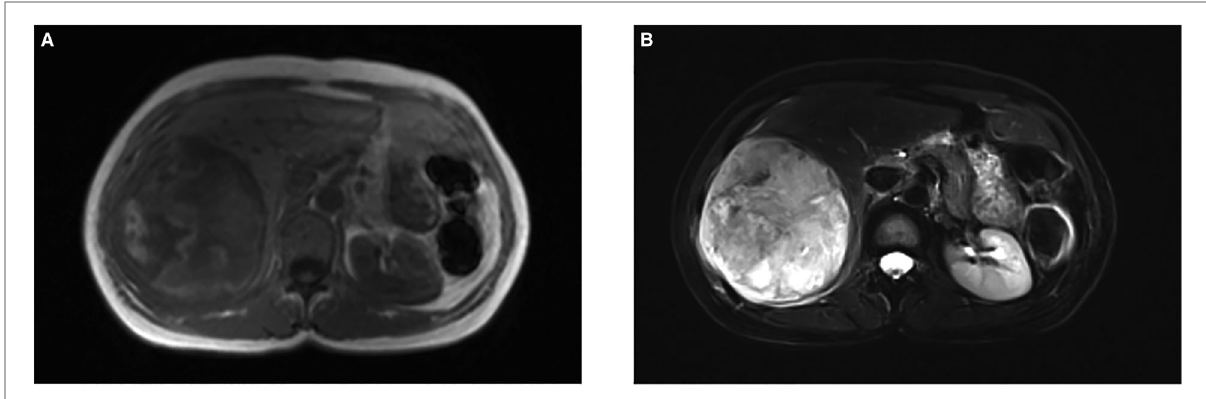
FIGURE 2 Findings of magnetic resonance imaging (MRI). ( A ) T1-weighted image of the nodule showed an iso-intensity lession. ( B ) T2-weighted image of the tumor presented a slightly higher intensity. (F) Diffusion-weighted image of the tumor was a marked hyper – intensity.